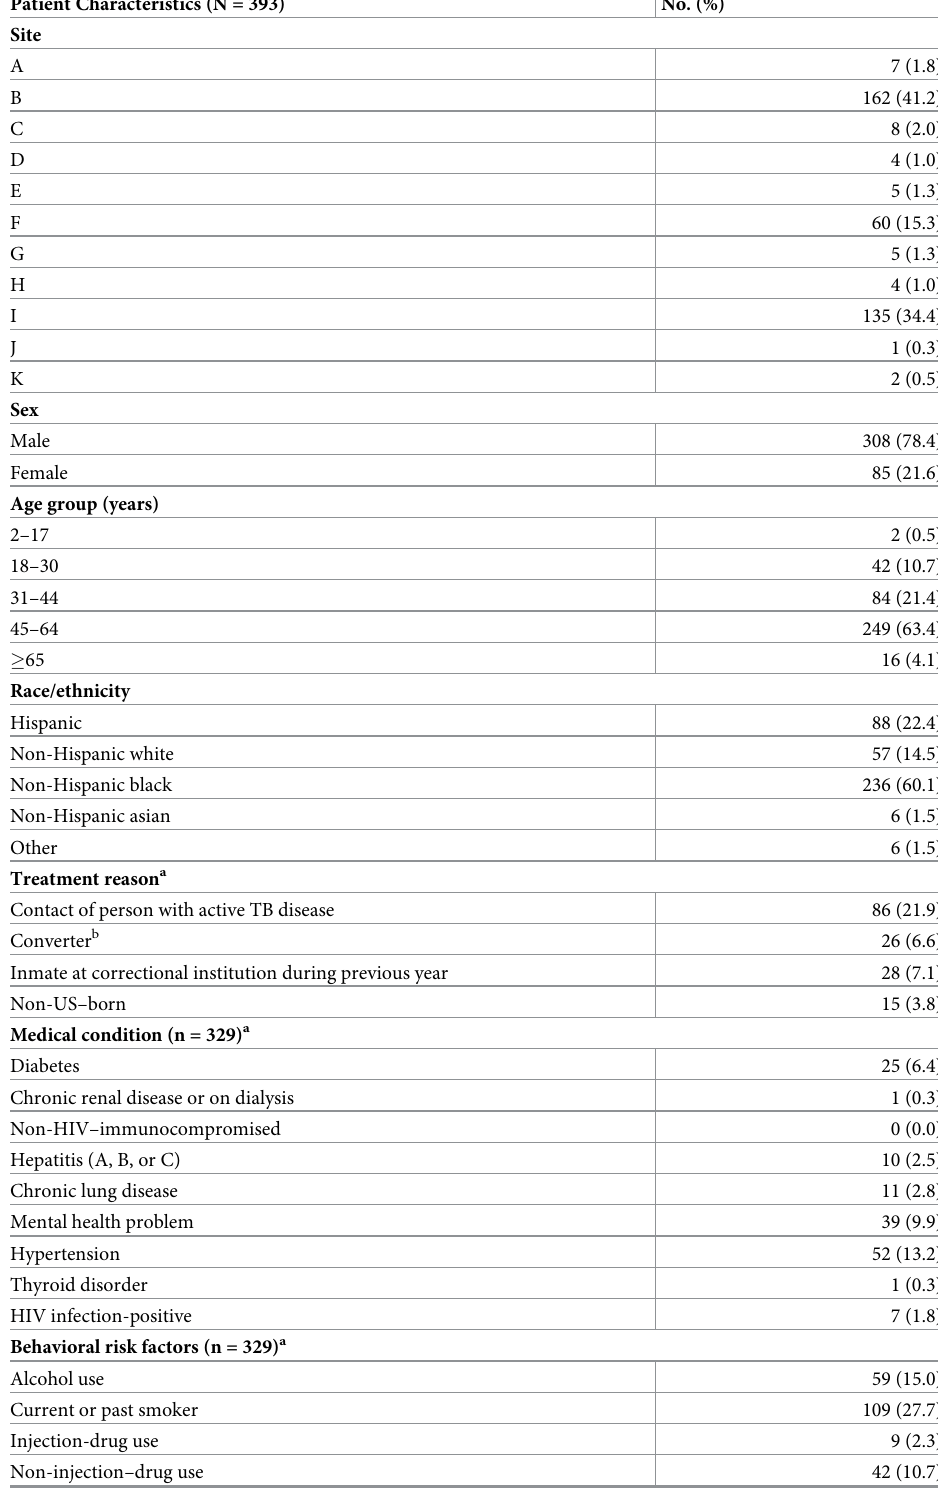
Table 1. Characteristics of persons experiencing homelessness for 11 program sites from July 2011-June 2015. Patient Characteristics (N =